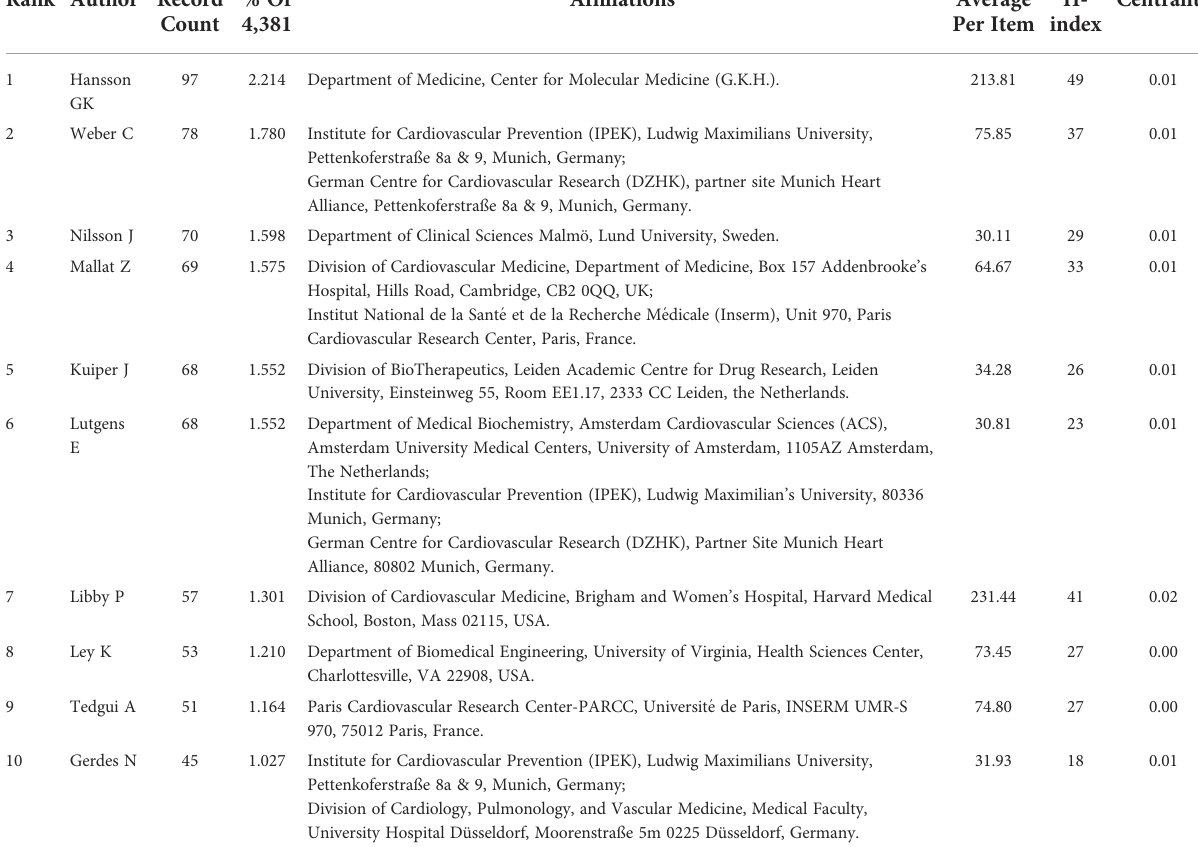
TABLE 3 Top 10 authors in T cell and